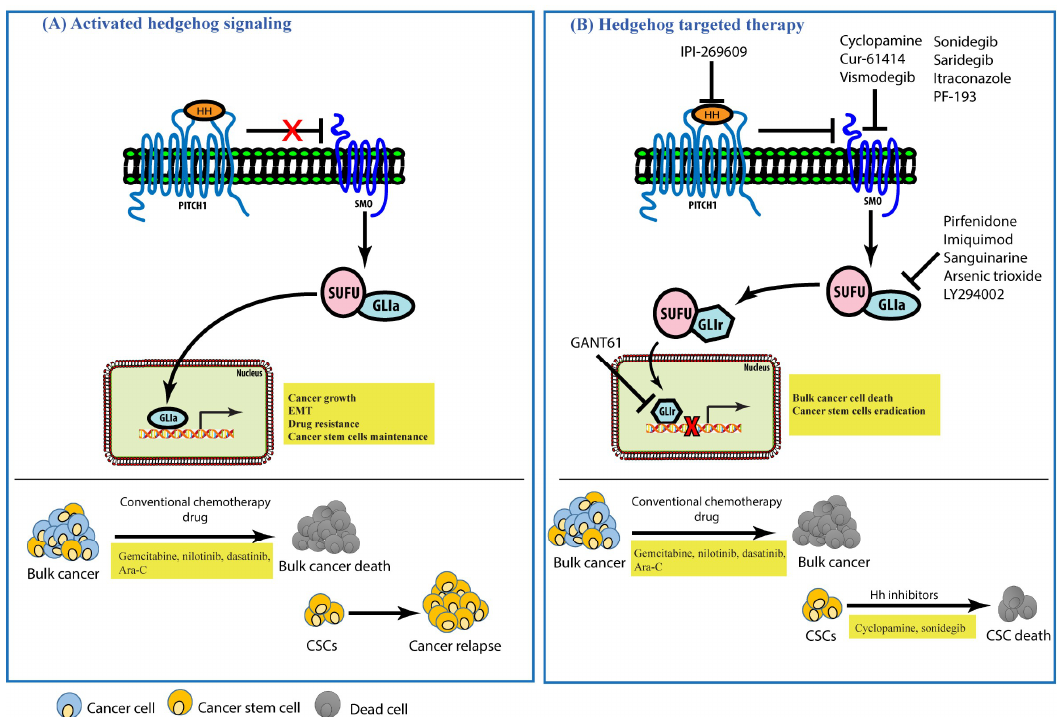
Figure 2. Schematic model of Hh activation and the therapeutic strategy for cancers. ( A ) In the presence of the Hh ligand, PTCH1 is internalized and SMO is activated, leading to the localization of GLI-1 in the nucleus. Gli-1 is activated and promotes the transcription of its target genes, which is important for the growth of cancer cells, promotion of epithelial–mesenchymal transition (EMT) mechanisms, drug resistance, and the maintenance of CSC population (upper). Conventional chemotherapy eliminates bulk cancer cells. However, residing CSCs escape from the therapy and trigger cancer relapse (bottom). ( B ) Inhibition by either Hh ligand, SMO, or GLI1 inhibitors led to the inactivation of Hh signaling. Gli-1 is suppressed by SUFU and fails to localize in the nucleus and activate Hh target genes (upper). Inhibition of Hh signaling together with conventional chemotherapeutics results in the death of cancer bulk cells and eradication of the cancer stem cell population which has escaped from conventional chemotherapeutics (bottom).